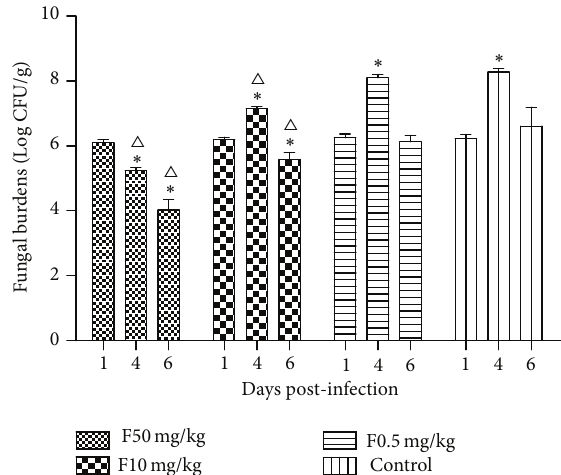
Figure 9: Renal fungal burdens of fluconazole treated mice ( 𝑛 = 5 per day). 50 mg/kg/d group showed a significant decline of renal fungal burdens, while, the other groups showed a transient increase during the experiment period. ∗ 𝑃 < 0.05 , 𝑡 -test, versus that of day 1. 󳵻 𝑃 < 0.05 , 𝑡 -test, versus that of control of the same time